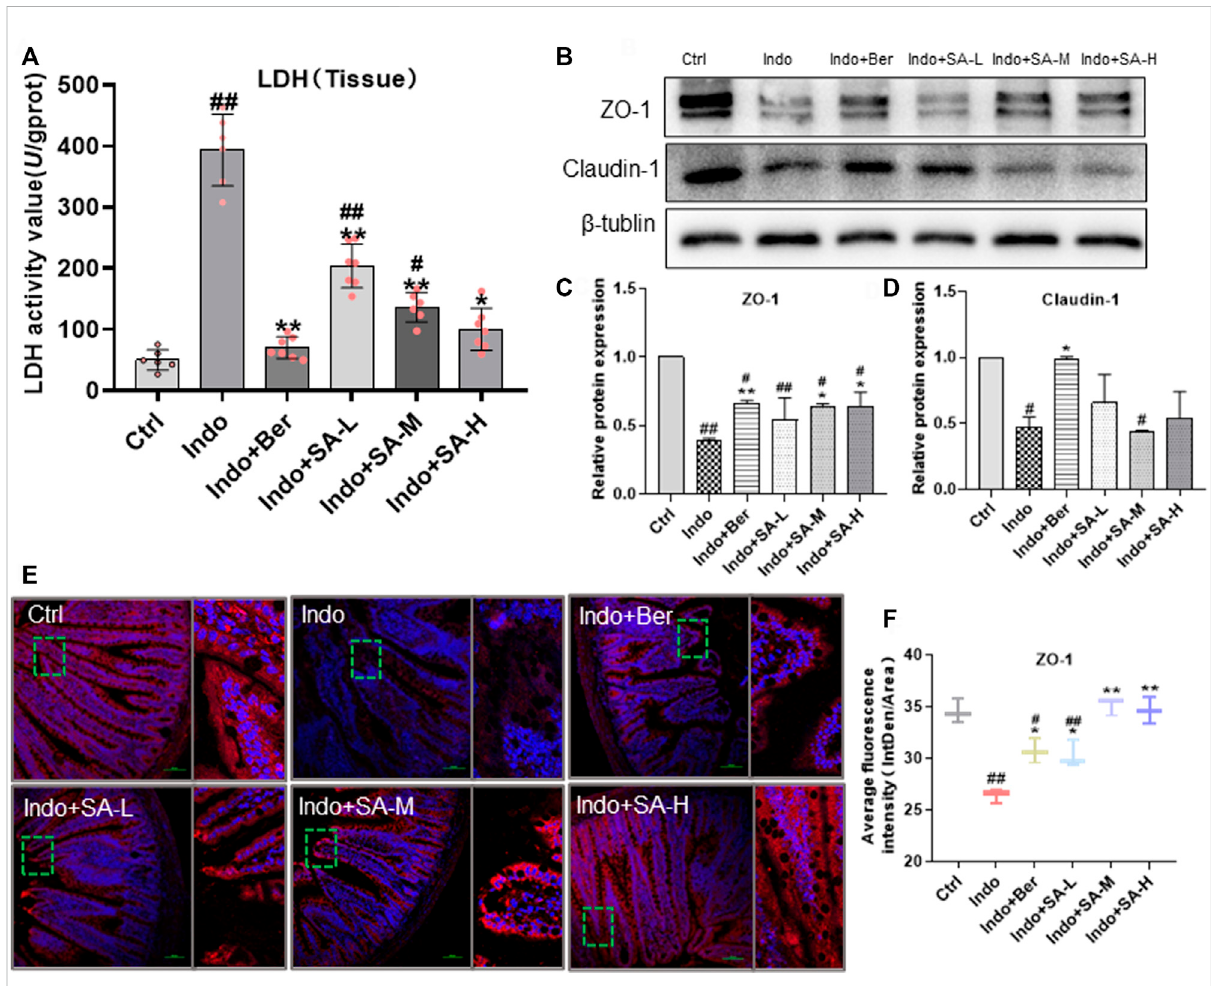
FIGURE 2 Protection of SA on mucosal barrier of jejunum in indomethacin-treated rats. Male SD rats were treated with indomethacin (Indo, 7.5 mg kg − 1 ) alone or with sanguinarine (SA, 0.33 mg kg − 1 , 1.0 mg kg − 1 , 3.3 mg kg − 1 , SA-L, SA-M and SA-H, respectively) or with berberine (Ber, 60 mg kg − 1 ).The jejunum tissuesamples of SD rats were collected and prepared according to the requirementsof the detection kit. Chemiluminescence was utilized to measure the levels of tissue lactate dehydrogenase (LDH) (A) . Western blot was used to measure the expression of tight junction proteins zonula occludens-1 (ZO-1) and claudin-1 (B – D) . The laser confocal immuno fl uorescence assay was used to detect the location and expression levels of ZO-1, and the small box represents the typical fl uorescence area, which is enlarged and placed to the right of the whole fl uorescence fi eld (E,F) . Data are presented as the mean ± SD ( n = 3). # p < 0.05 and ## p < 0.01 vs. control (Ctrl). * p < 0.05 and ** p < 0.01 vs. indomethacin